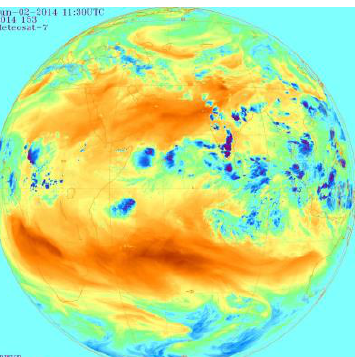
Figure 10. Infrared water vapour over Iran on second of July